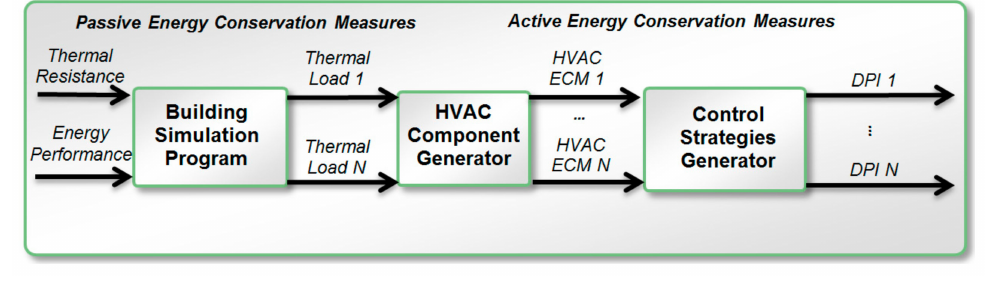
Figure 7. Scenario Generation Module.